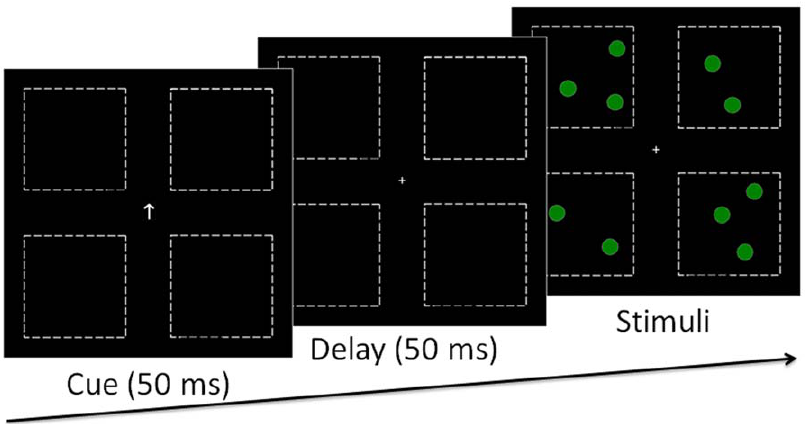
Figure 5. Example of a trial used in Experiment 3. The cue indicates the location of the two quadrants that need to be processed. The example here shows a ‘bilateral’ trial for the upper portion of the visual field.